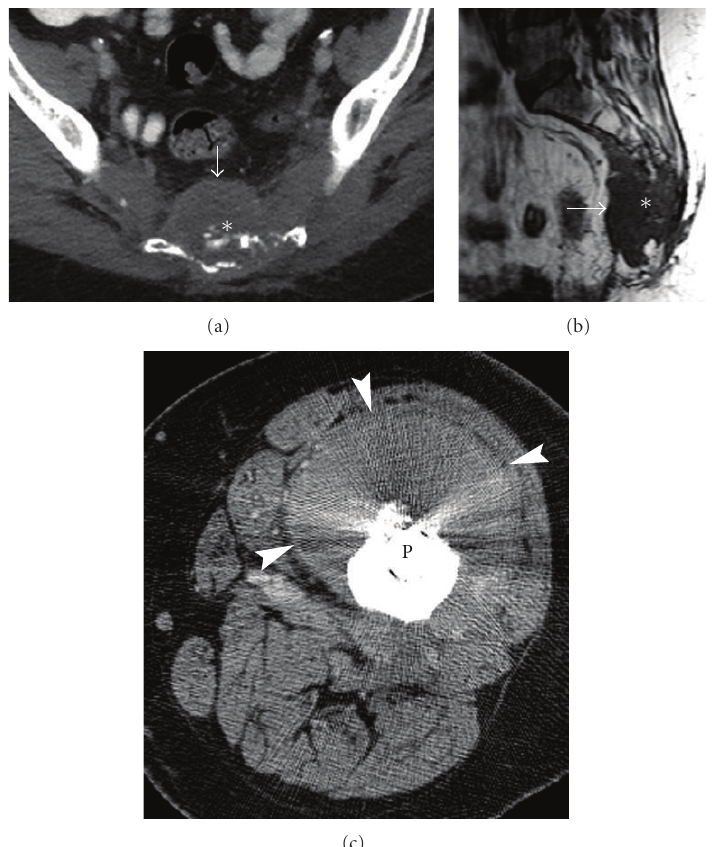
Figure 9: Chordoma. A 64-year-old female presenting with low back pain, diagnosed with an advanced sacral chordoma. Axial CT (a) and sagittal T1 midline image (b) demonstrate a large midline mass with internal calcification, destroying the sacrum (asterisk) and infiltrating the presacral space anteriorly and epidural space posteriorly. Axial CT (c) showing a large soft tissue metastasis (arrowheads) in the thigh around the femur. Hardware artifact is from an intramedullary rod (P) internally fixing the pathological fracture of the femur.